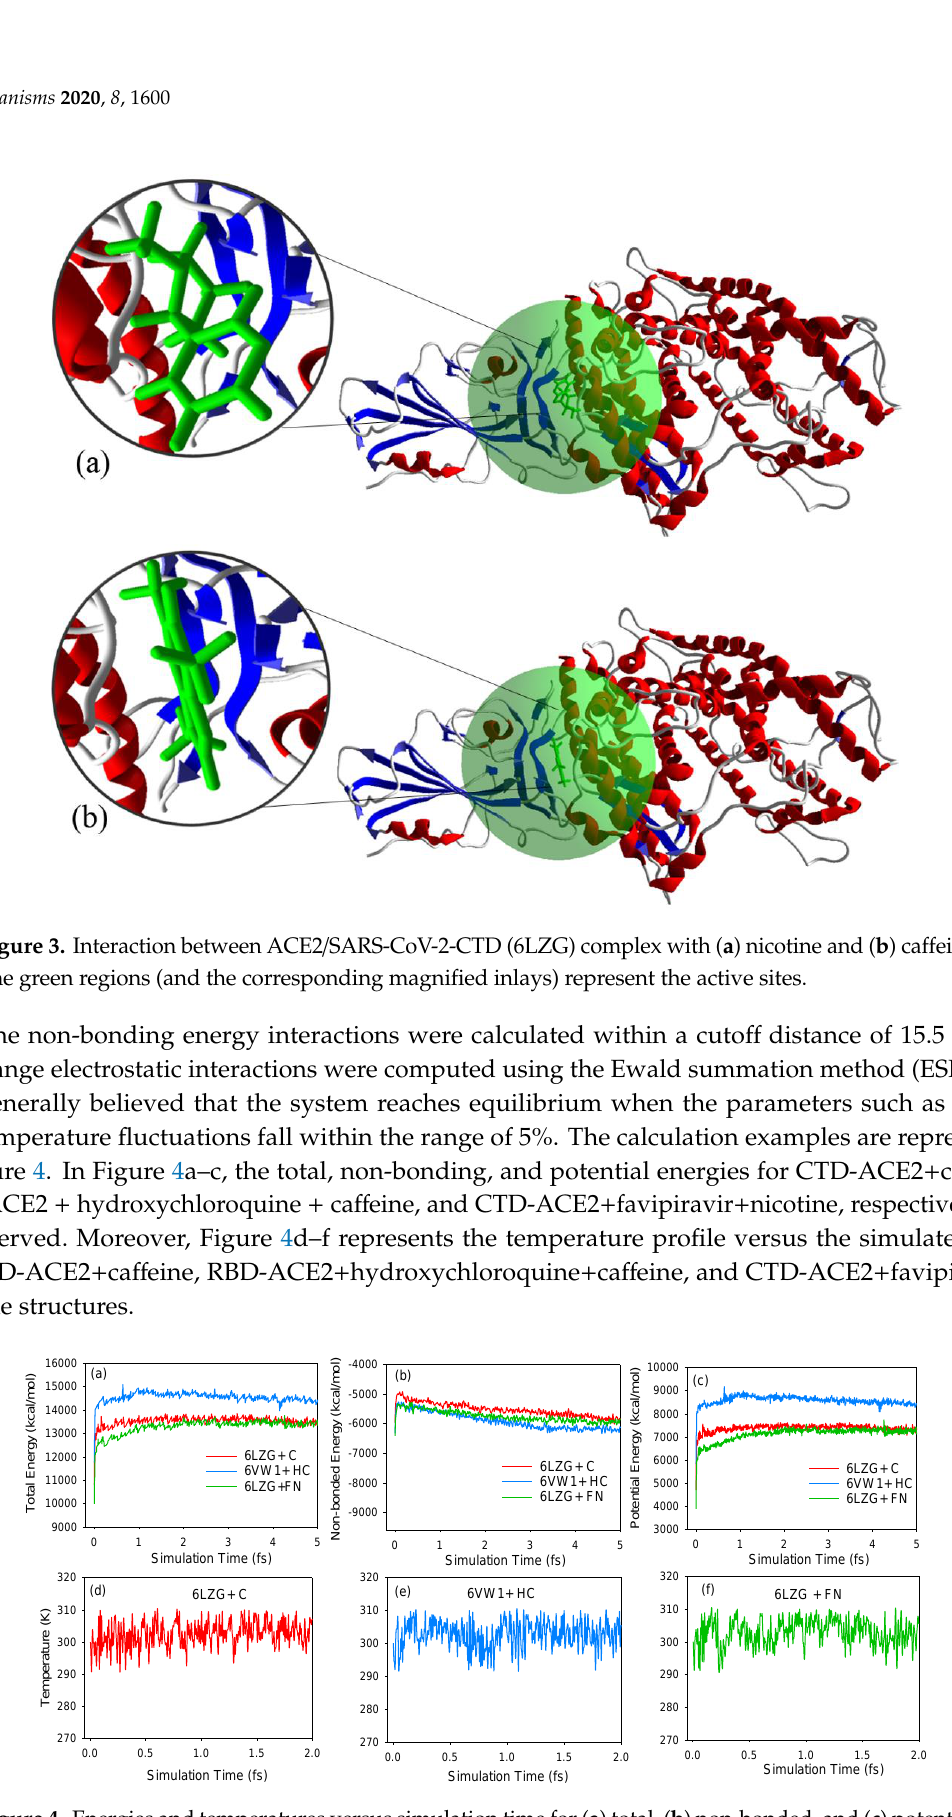
Figure 4. Energies and temperatures versus simulation time for ( a ) total, ( b ) non-bonded, and ( c ) potential energies. The plots show the temperatures for ( d ) CTD-ACE2+caffeine (6LZG+C), ( e ) RBD-ACE2+hydroxychloroquine+caffeine (6VW1+HC), and ( f ) CTD-ACE2+favipiravir+nicotine (6LZG+FN).